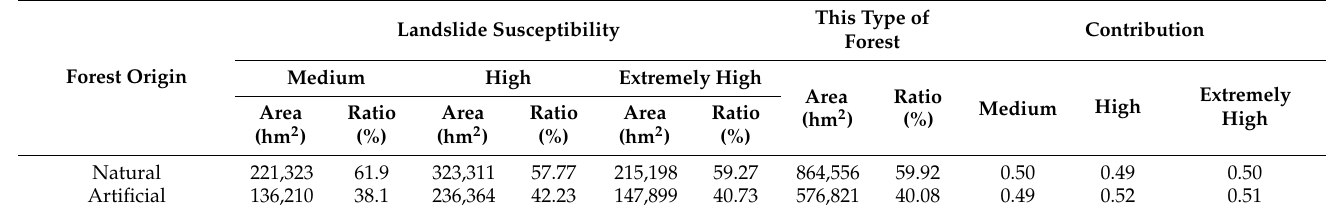
Table 2. Relationship between forest origin and landslide susceptibility in Bijie